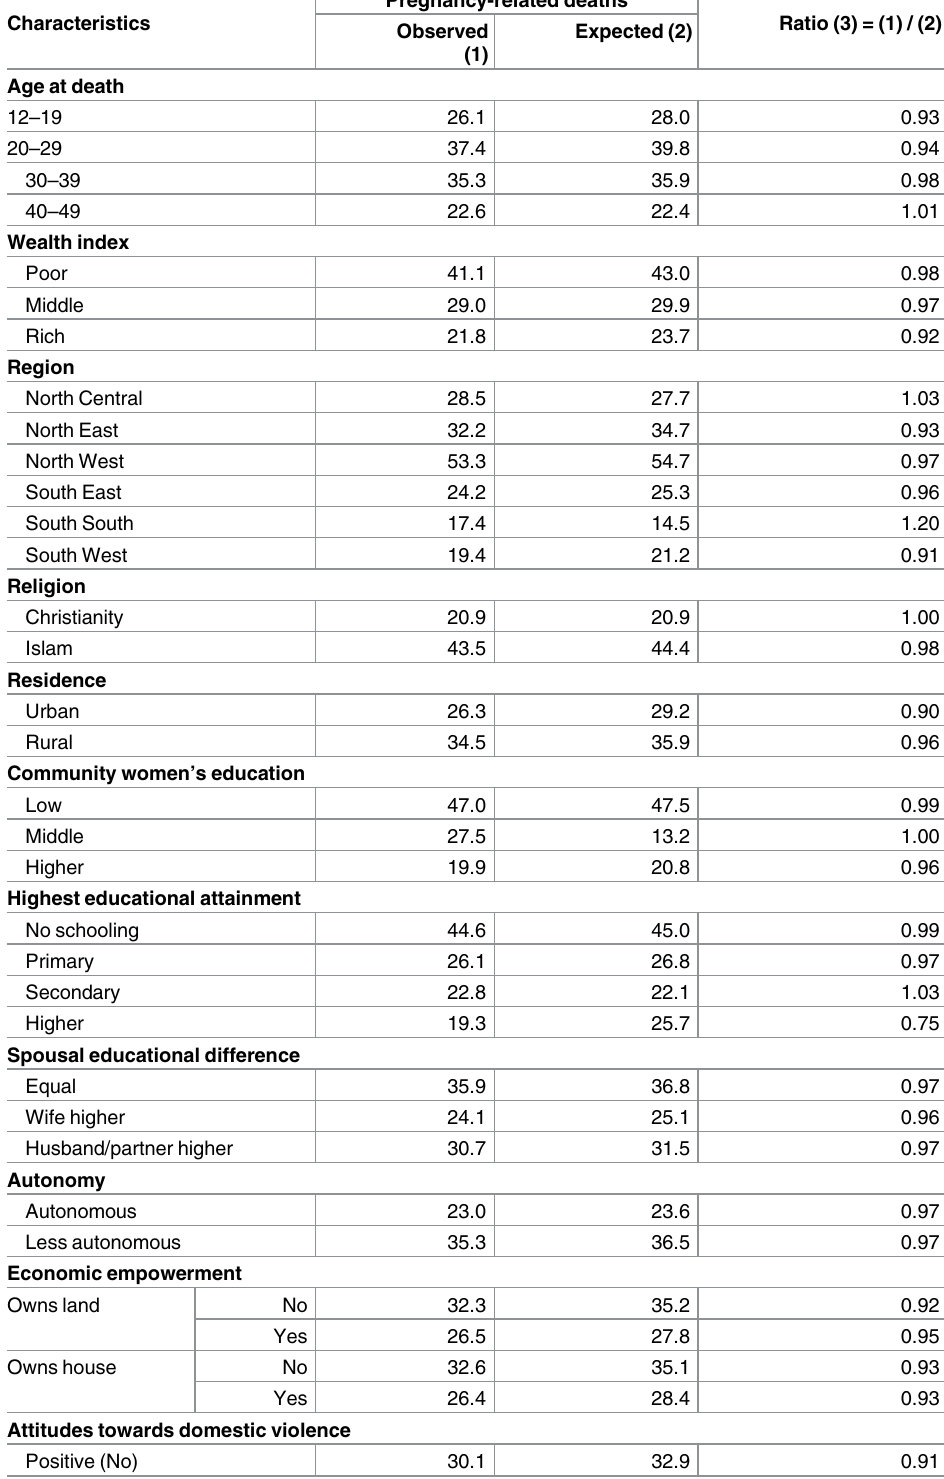
Table 6. Observed and expected proportion of pregnancy-related deaths by selected characteristics identified by the direct sisterhood method.